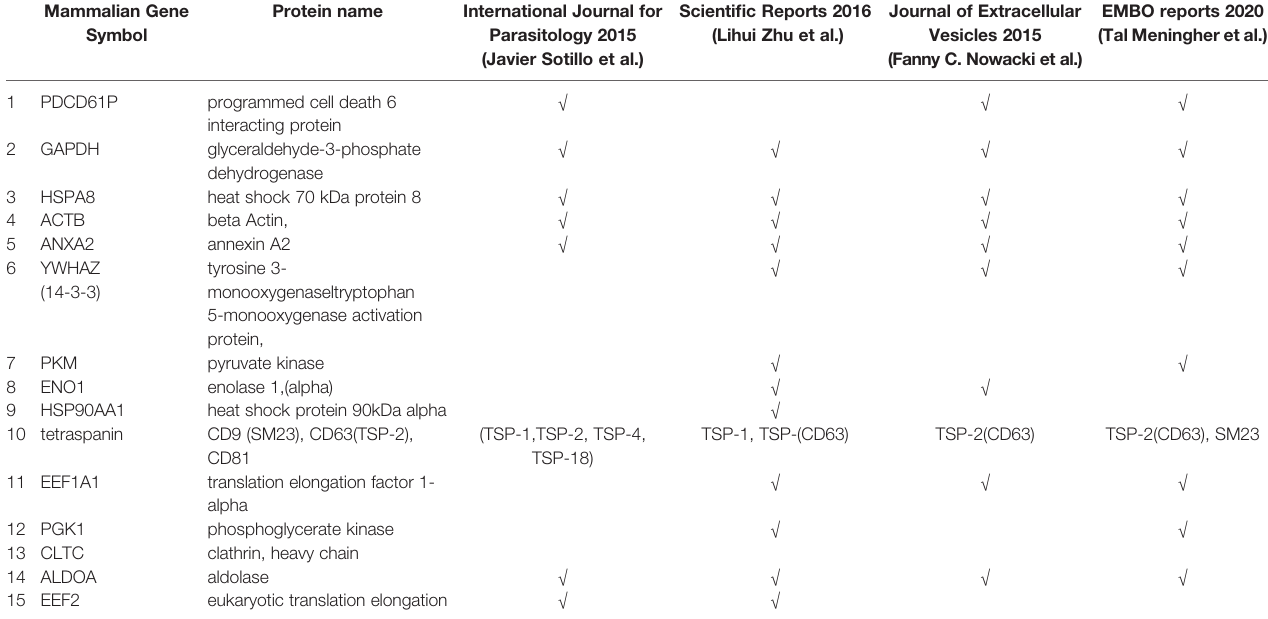
TABLE 2 | Proteomic analyses of schistosome-derived EVs.